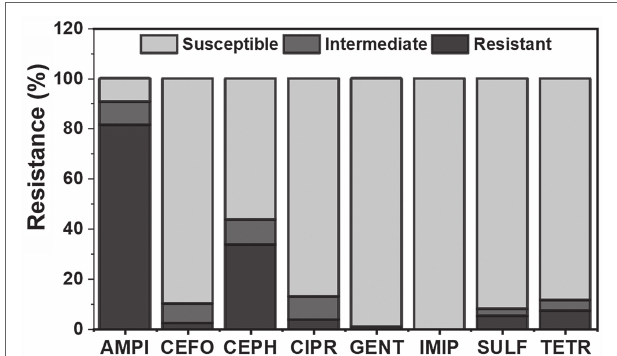
FIGURE 4 | Distribution of antibiotic resistance (resistant, intermediate, and susceptible) among all materials (wastewater, foliage, leachate, and soil) for eight different antibiotics tested (AMPI, ampicillin; CEFO, cefoperazone; CEPH, cephalothin; CIPR, ciprofloxacin; GENT, gentamicin; IMIP, imipenem; SULF, sulfamethoxazole; and TETR, tetracycline) throughout romaine lettuce production (days 0, 7, and 14, post-harvest day 7, and post-harvest day 14). Total E. coli isolates were n =